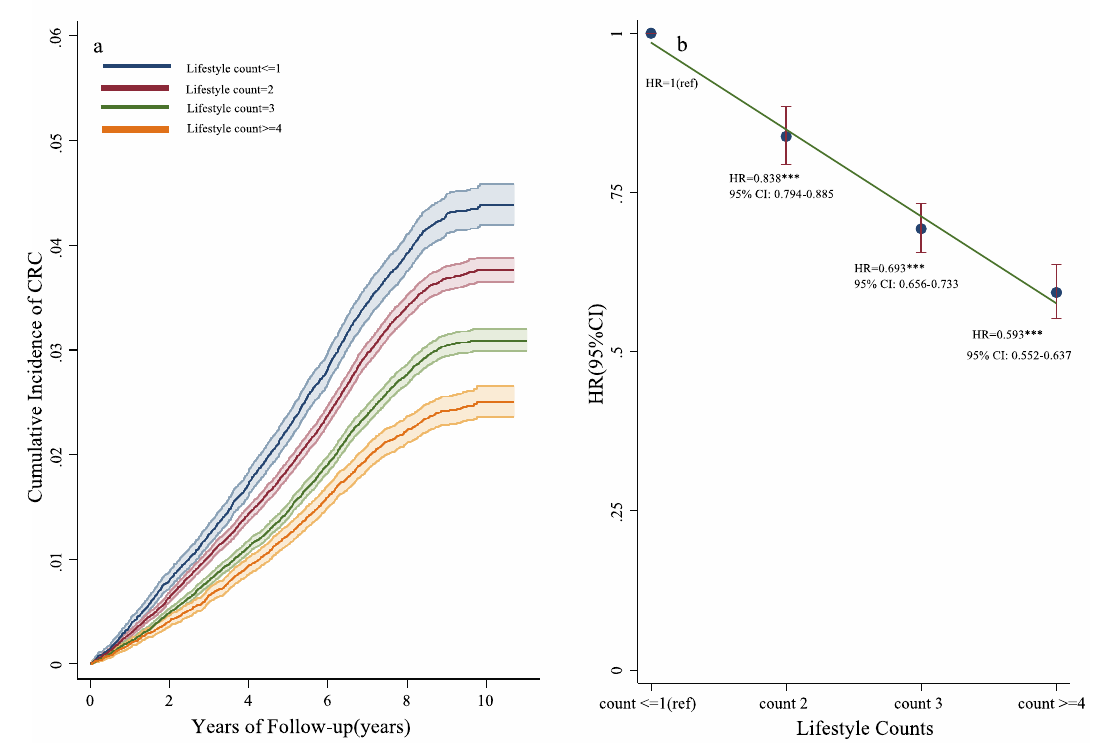
Figure 4. Effects of healthy lifestyle counts on the risk of incident CRC in the UKB cohort.